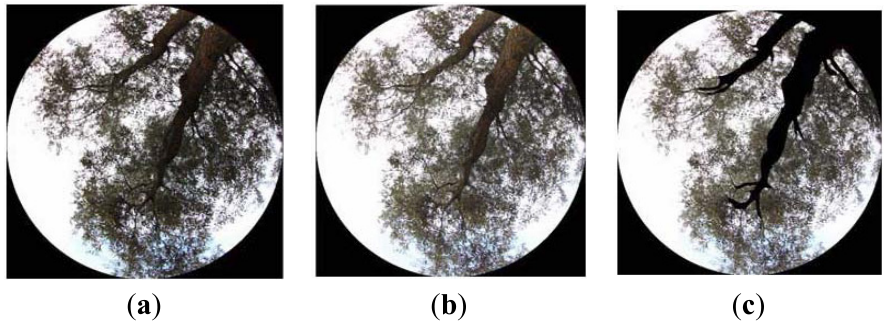
Figure 8. Edition of photographs, ( a ) Original image, ( b ) Gamma correction, ( c ) Elimination of non-green vegetation elements